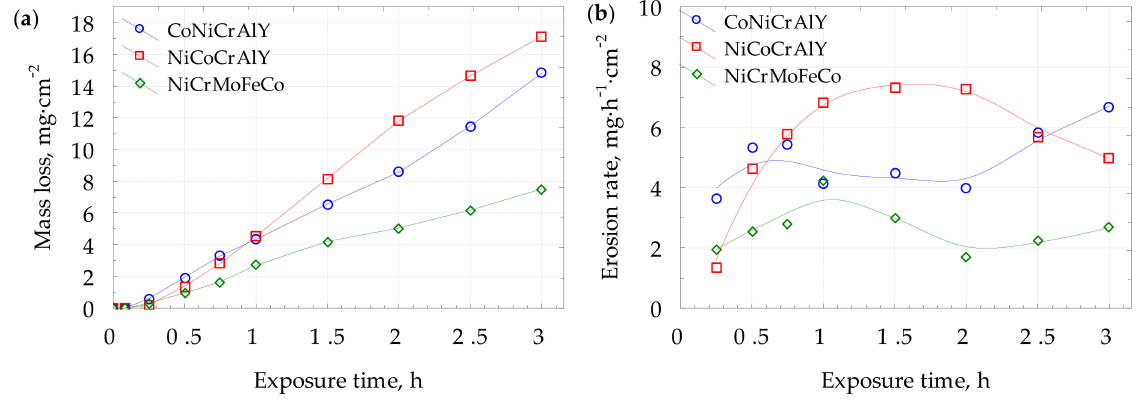
Figure 12. Cavitation erosion curves: ( a ) mass loss; ( b ) erosion rate